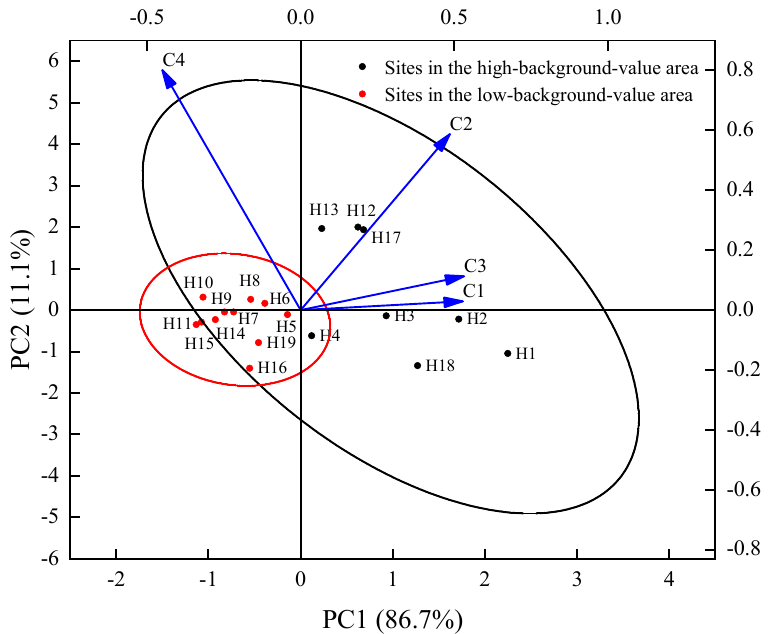
Figure 8. Biplot for four PARAFAC components and each sample as first two principal components.